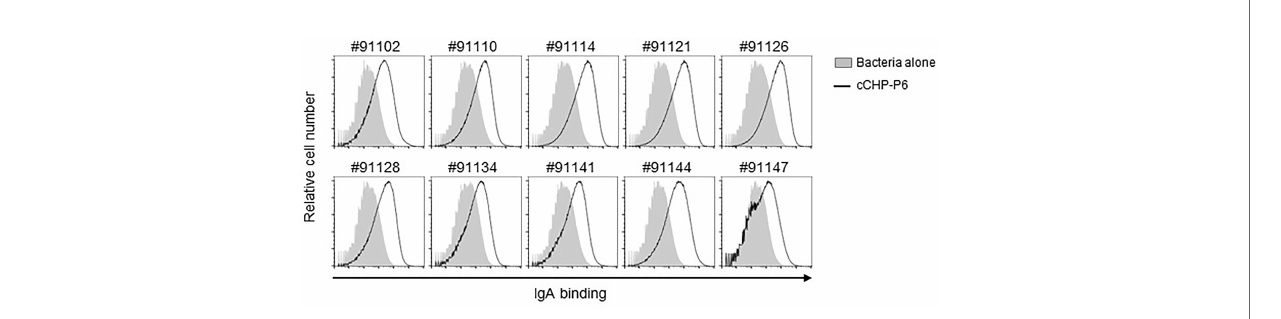
FIGURE 4 | P6-speci fi c IgA binds to diverse NTHi clinical isolates from patients with otitis media. Nasal washes collected from mice 2 weeks after the booster immunization were incubated with 10 NTHi clinical isolates of different strains (indicated by the numbers above the graphs). Antibody binding was detected by fl ow cytometric analysis using a secondary antibody. Data are representative of three independent experiments.